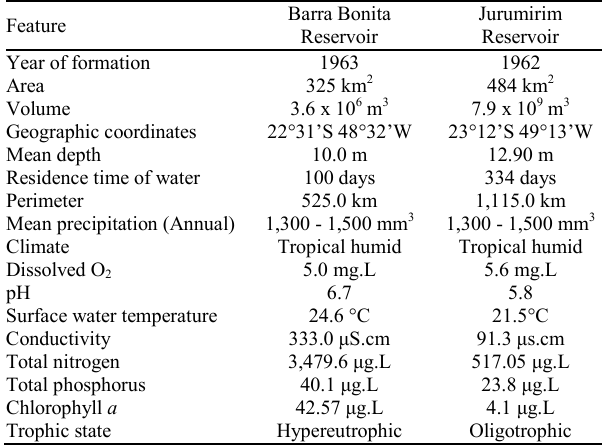
Table 1. Barra Bonita Reservoir and Jurumirim Reservoir: morphometric, geographical, and limnological (annual average for reservoirs) features. For Barra Bonita Reservoir, according to Tundisi et al . (2008), and for Jurumirim Reservoir, according to Nogueira et al .